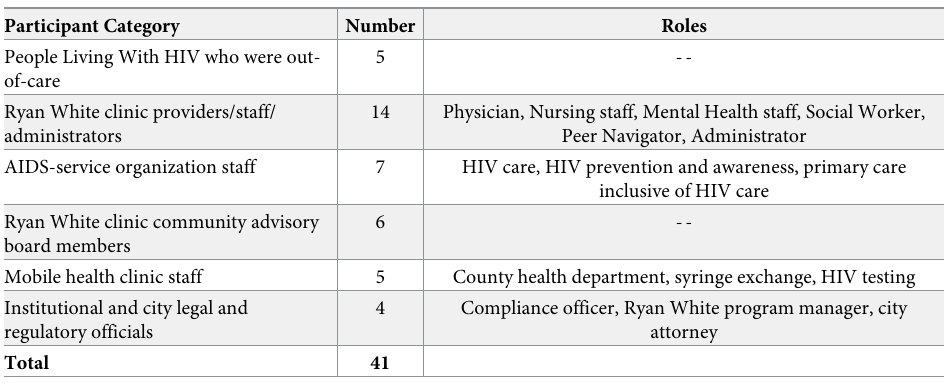
Table 1. Participant